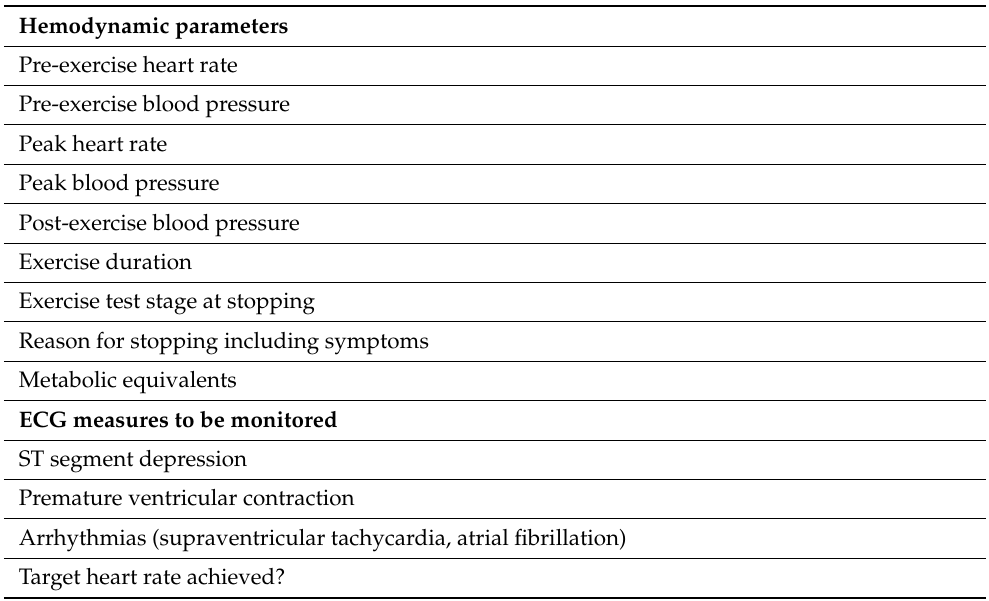
Table 1. Standard hemodynamic parameters and 12-lead ECG measures to be recorded at baseline, end of each stage, and at peak exercise.